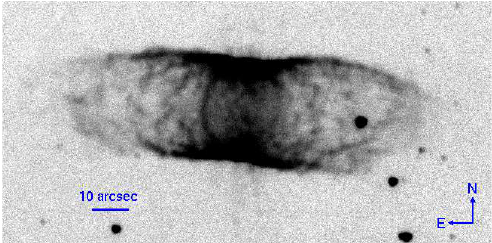
Figure 1. Continuum-subtracted H 2 2.12 µm line image of IC 4406 obtained with the Canada-France-Hawaii Telescope . The bipolar lobes have sharp boundaries and are clearly confined by an external medium.